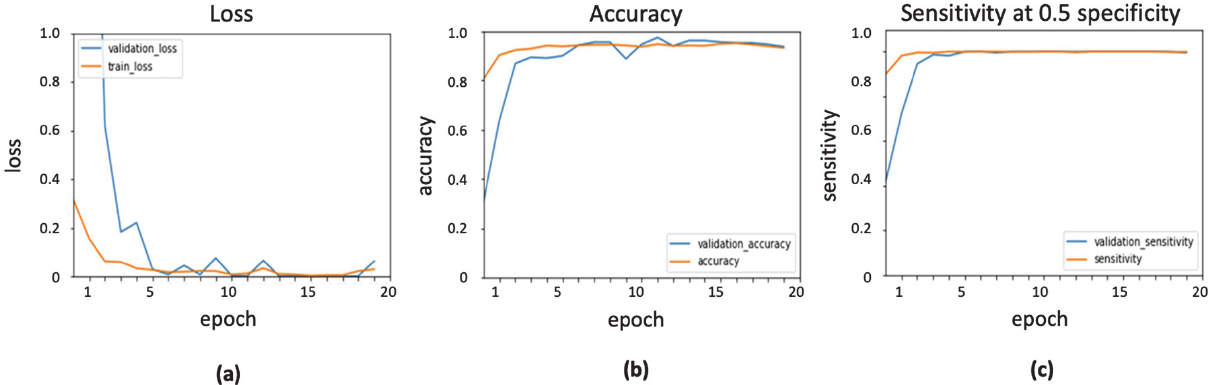
Figure 5. Output obtained using ADAGrad optimizer: ( a ) loss function; ( b ) accuracy; ( c ) sensitiv- ity.